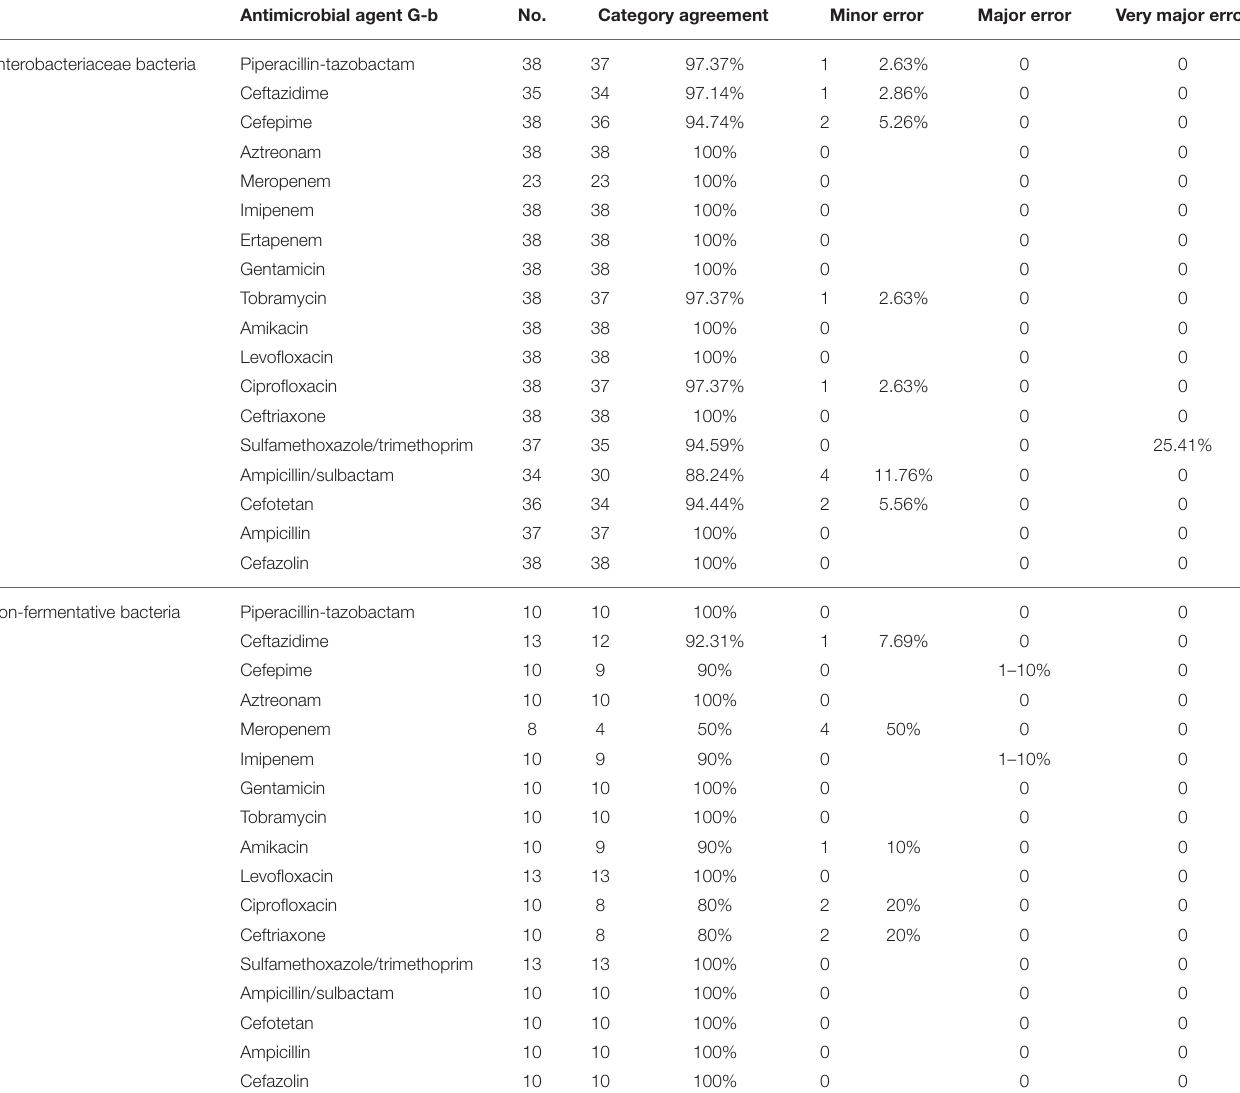
TABLE 2 | Bacterial/antimicrobial combinations and errors in gram-negative bacteria isolates from positive blood cultures. Antimicrobial agent G-b